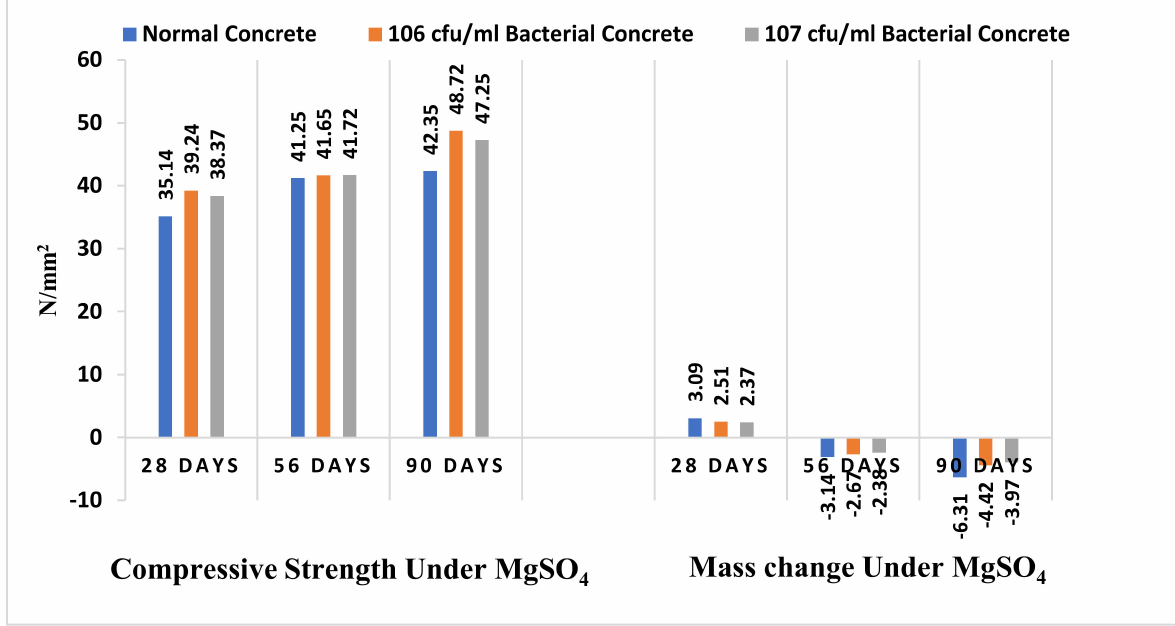
Figure 8. Effect of sulphate attack on bacterial concrete with different interval